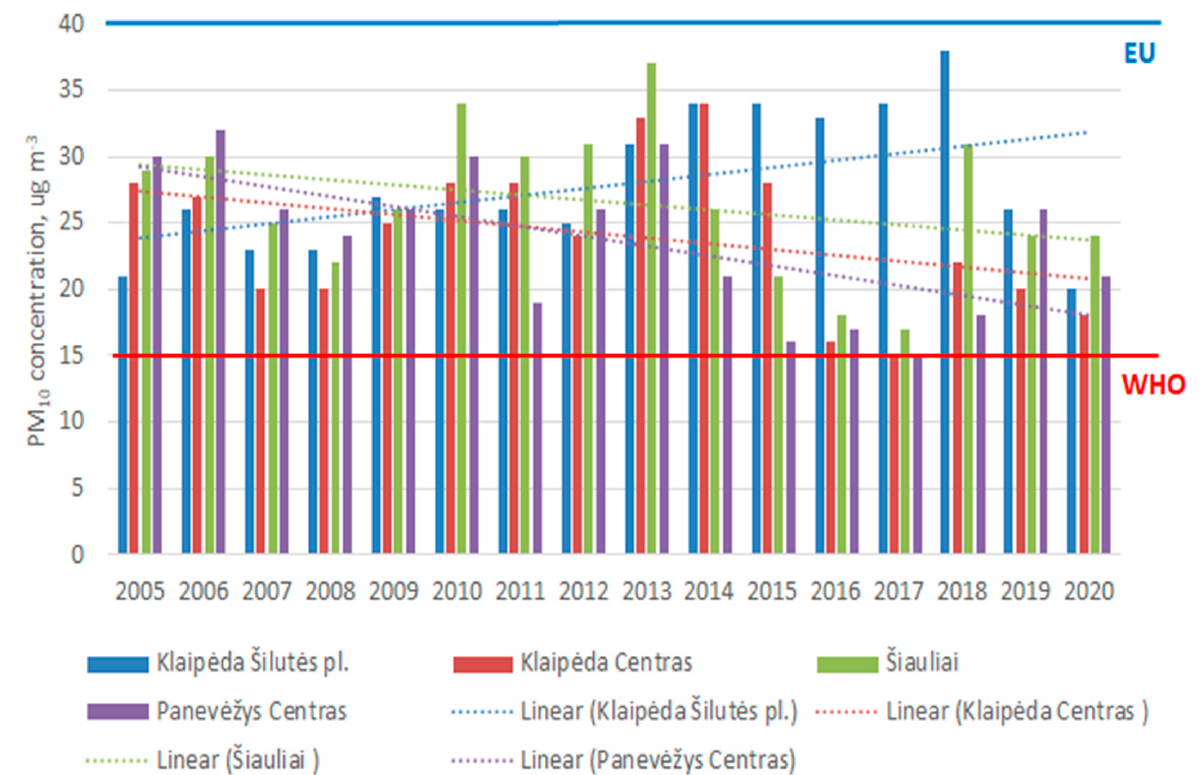
Figure 7. Annual mean PM 10 concentration and trends in biggest cities.